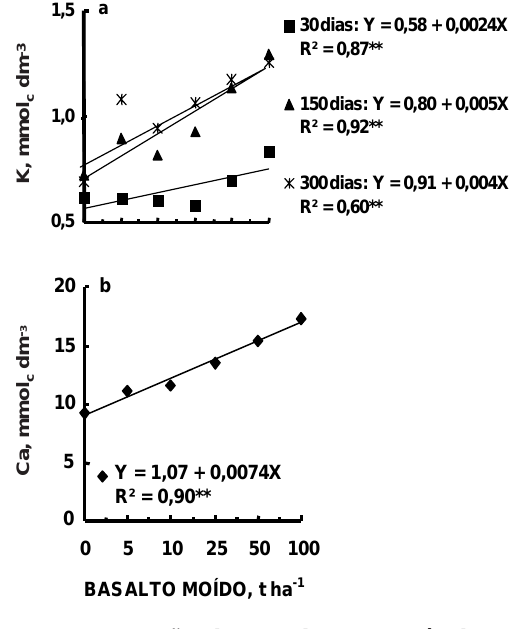
Figura 1. Concentração de K e de Ca trocáveis no solo. a: Média de solos e de rochas, aos 30, 150 e 300 dias de incubação. b: Média de solos, de rochas e de períodos de incubação.